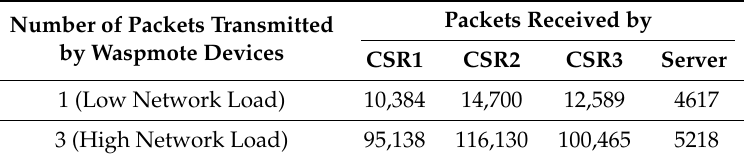
Table 16. Number of packets received by CSR devices and BLE server for each Waspmote device configuration in Collaborative Mesh with CSR devices retransmit each packet once.